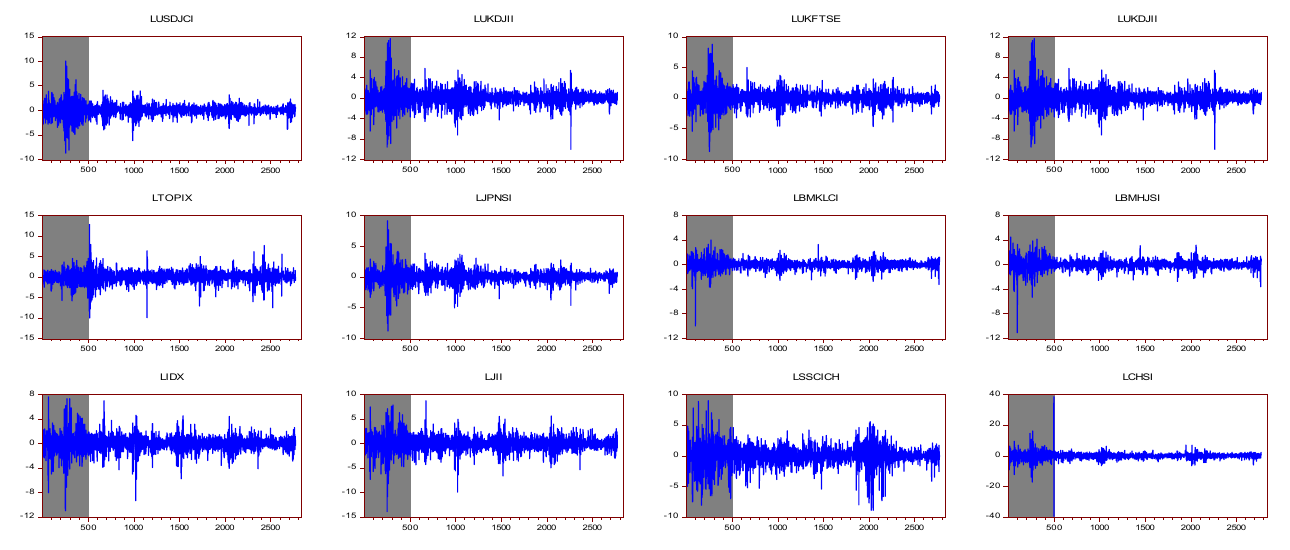
Figure 2. Stock prices return movement.